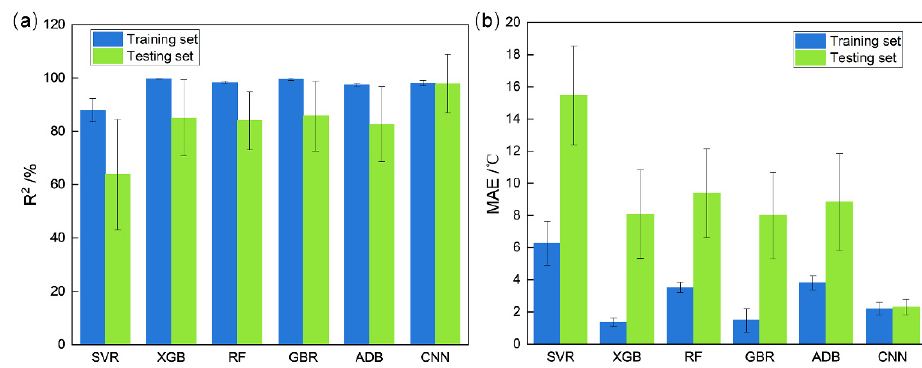
Figure 5. The results of different machine learning methods: ( a ) the results of R 2 ; ( b ) the results of MAE.